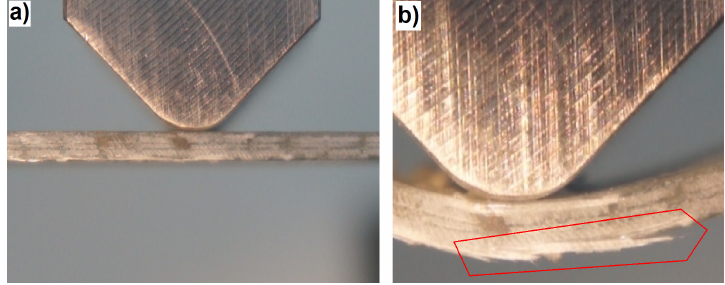
Figure 11. Photograph showing the main failure in the 3D laminate, direction P : ( a ) Beginning of the bending test; ( b ) 73 s of the test, right after the occurrence of the main failure.